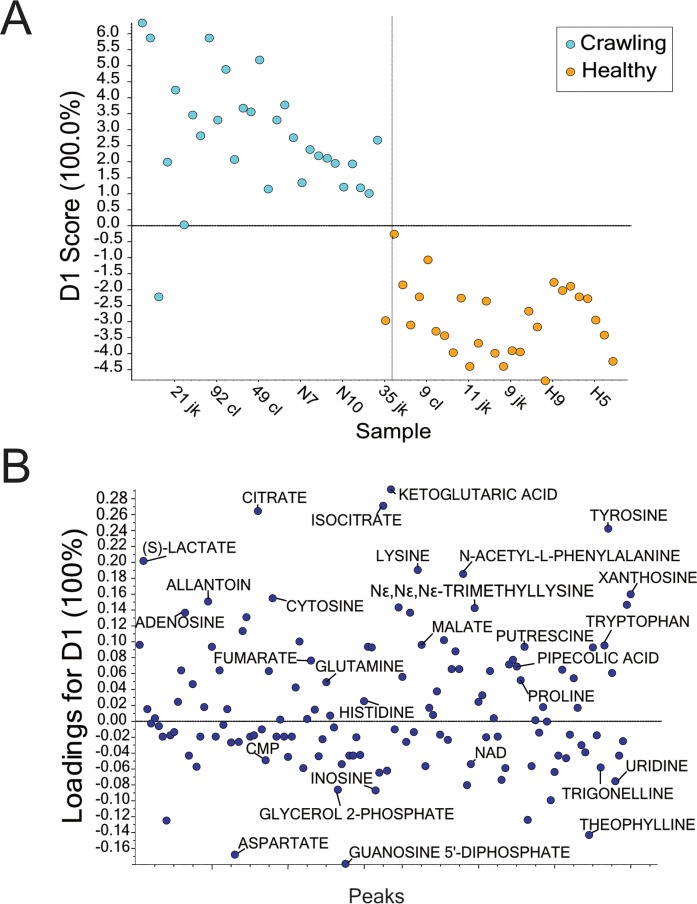
Results of supervised principal component analysis of metabolites detected by LC-MS/MS in bee muscle.Muscle was collected from 28 healthy and 29 crawling bees over two years (2016 and 2017). (A) Scores plot. Data were log transformed and Pareto scaling was used to account for differences in peak magnitude and minimize the noise of small variables. (B) Loadings plot. The location of each metabolite in relation to 0 indicates the strength of its contribution on the principal component: metabolites further from 0 contributed more than those closer to 0, and metabolites above 0 were associated with crawling bees whereas those below 0 were associated with healthy bees. Metabolites are arranged along the x-axis according to retention time.